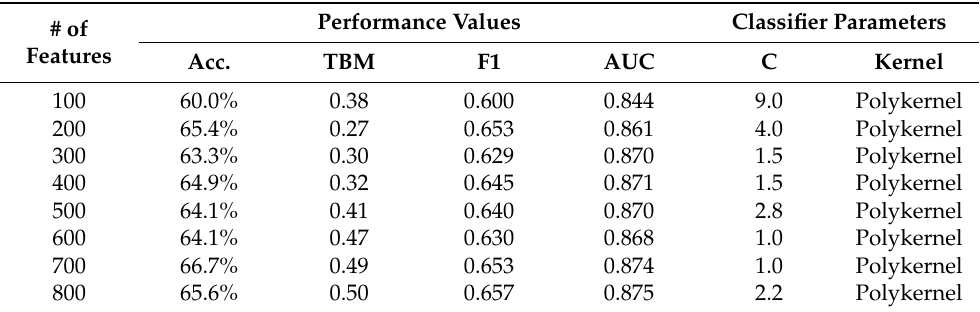
Table 5. The best performance of SVM over different feature sets. Where “Acc.” denotes the accuracy, “TBM” denotes the time to build model (training time), “F1” denotes the F-score, and “AUC” denotes the area under the ROC curve.